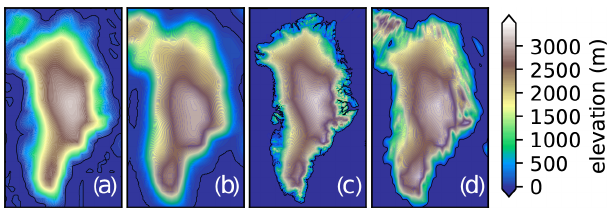
Figure 1. The climate model topography for the PD (a) is from the ERA-Interim data set, and that for the LGM (b) is from the CCSM4 simulation. The model topography used for the PD is ETOPO (c) , and ICE-6G is used for the LGM (d) . For the plot all topography below 5m was considered sea level for the climate